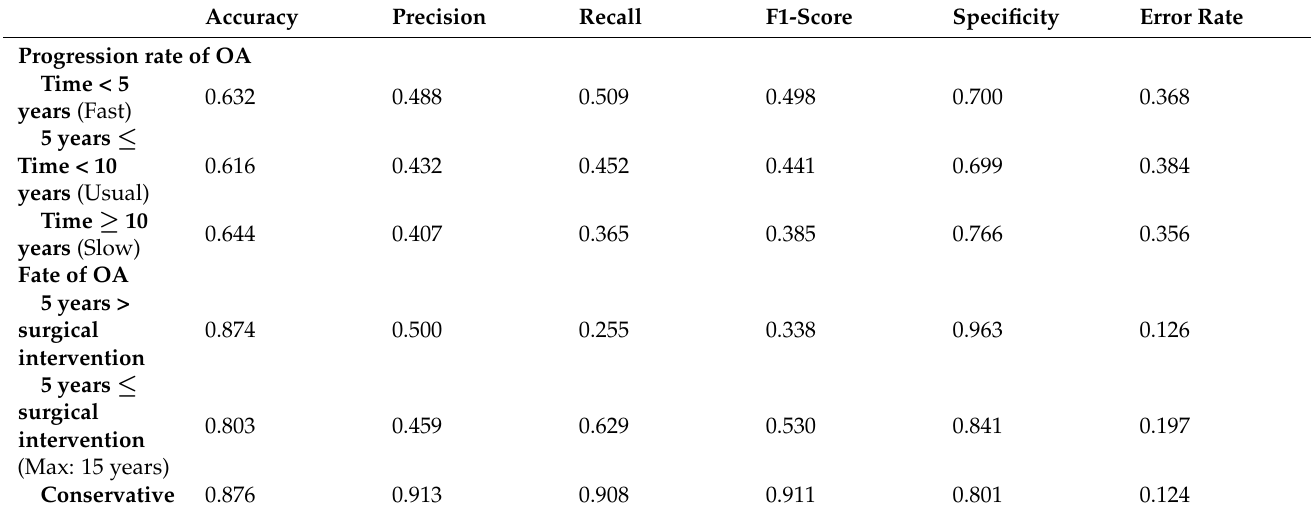
Table 4. Performance of model.